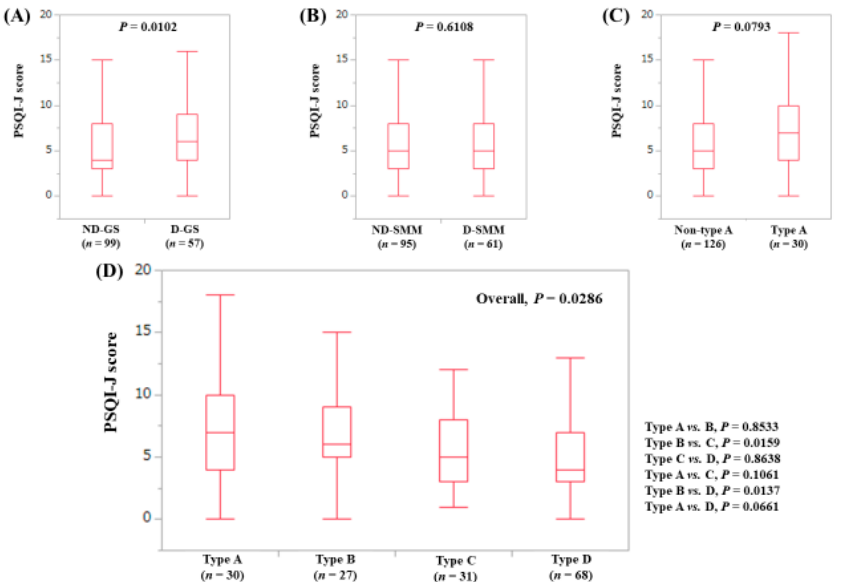
Figure 3. PSQI ‐ J score stratified by GS and SMM for LC cases ( n = 156). ( A ) Non ‐ decreased GS vs. decreased GS. ( B ) Non ‐ decreased SMM vs. decreased SMM. ( C ) Non ‐ type A (type B, C and D) vs. type A. ( D ) Comparison among four types (type A, B, C and D).